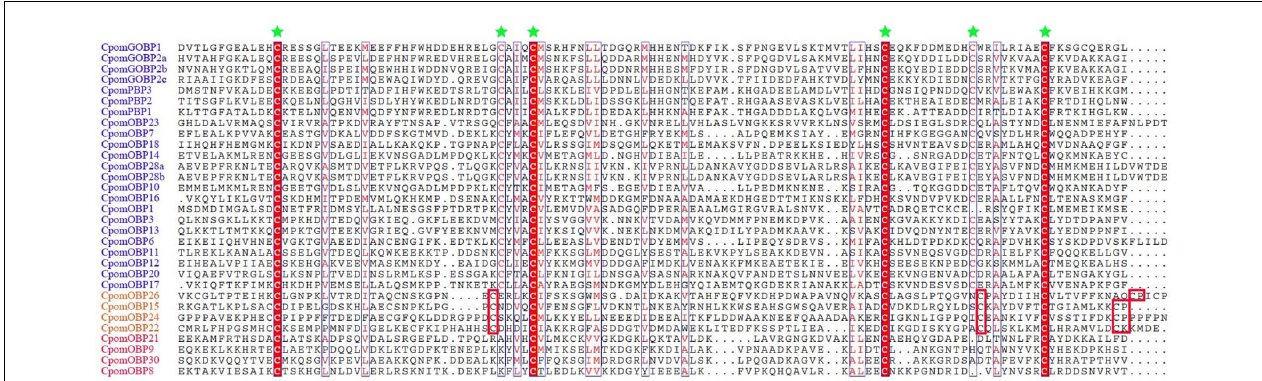
FIGURE 1 | Amino acid alignment of various C. pomonella OBP family members. The alignment was performed by MAFFT v7, aligned sequences were depicted with ESPript 3.0 server (http://espript.ibcp.fr/ESPript/cgi-bin/ESPript.cgi). Highly conserved cysteine residues are marked by green stars. The gene IDs of classic, plus-C, and minus-C OBPs are shown in blue, orange and red color, respectively. Only the cysteines which are conserved in all of alignment sequences are highlighted in red block. Seven classic and two atypical OBPs are not shown in this figure.